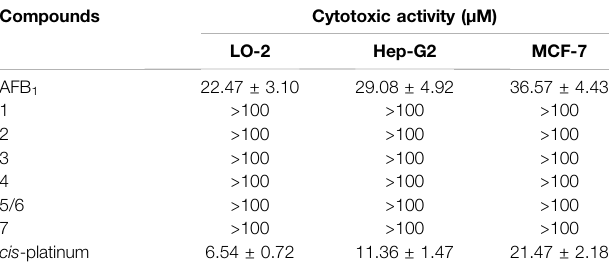
TABLE 4 | Cytotoxic activity of seven degraded products and a fl atoxin B 1